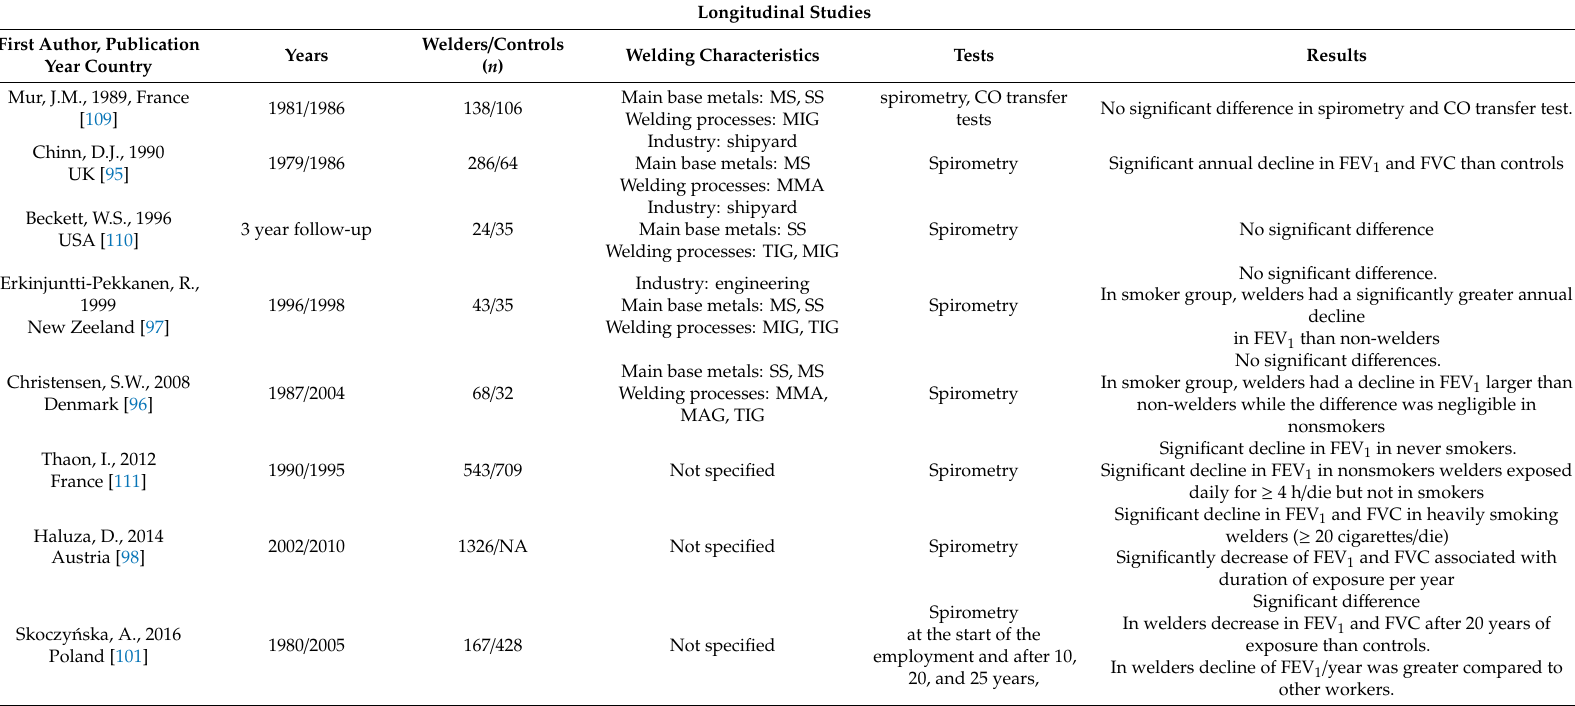
Table 2. Longitudinal study of lung function in